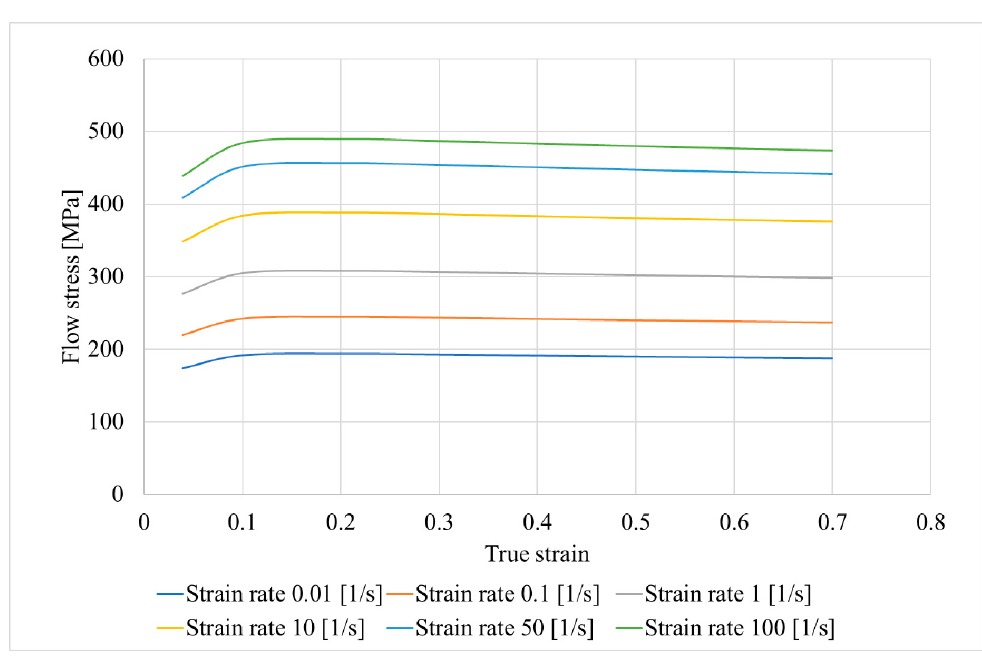
Figure 5. Total velocity change of the tracked points during the third pass (the numbers near the curves correspond to the points in Figure 3).